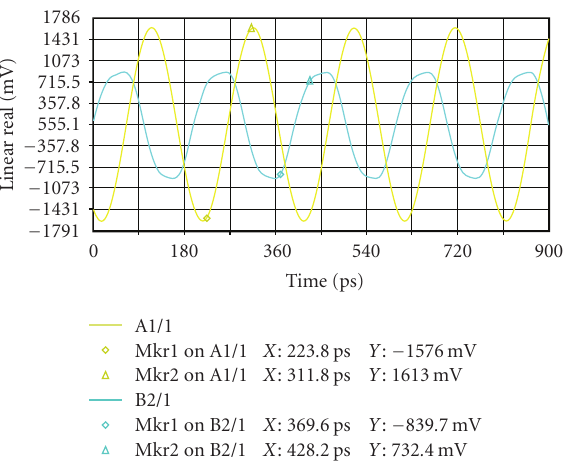
Figure 5: Measured NLTL time-domain waveforms for a 13.9 dBm input at